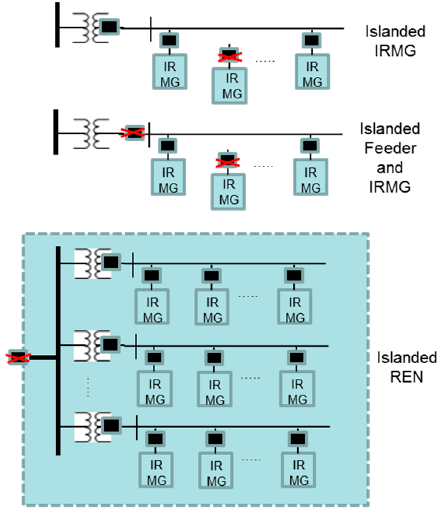
Figure 20. Islanded IRMG, feeder and REN.